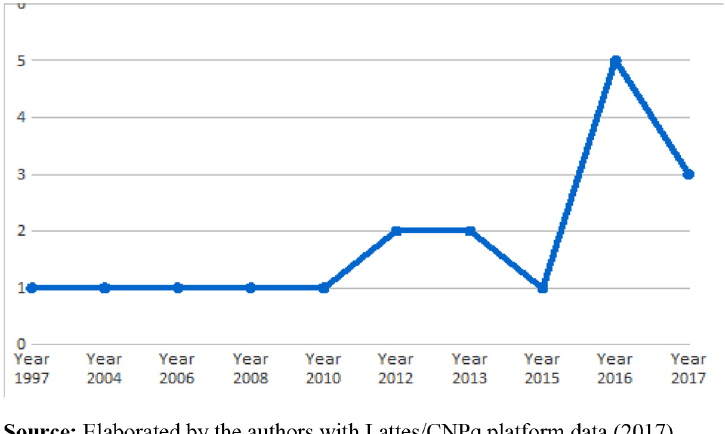
Figure 7. Number of research groups created